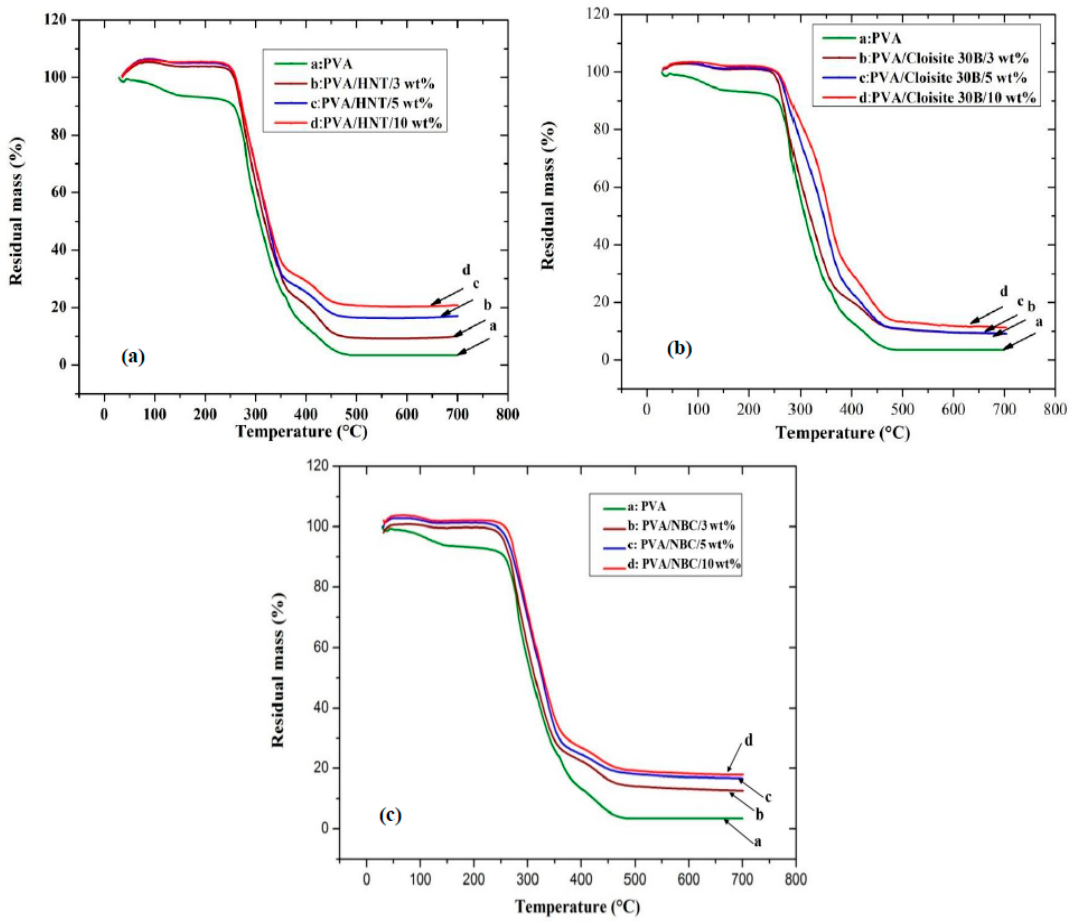
Figure 10. TGA curves for PVA bionanocomposites reinforced with ( a ) HNTs, ( b ) Cloisite 30B clays, and ( c ) NBCs.